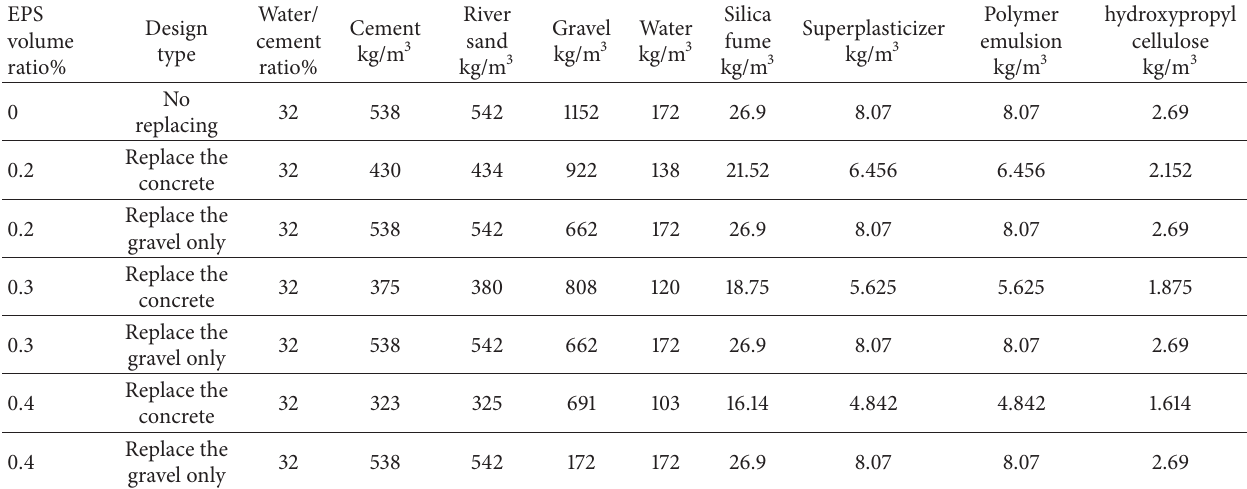
Table 1: Proportion of EPS concrete mixes.